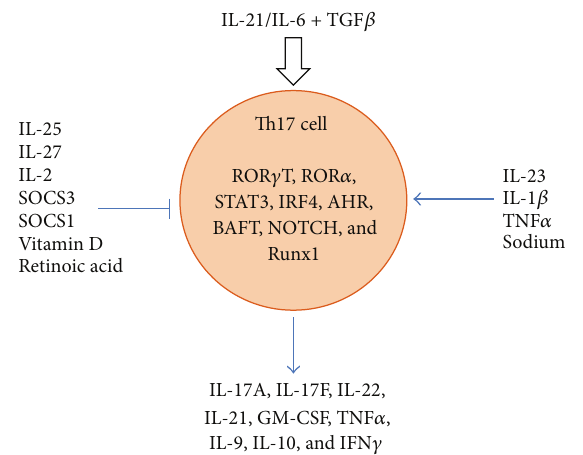
Figure 1: The world according to Th17 cells. Th17 cell induction occurs through combination of IL-6 and TGF 𝛽 , or IL-21 and TGF 𝛽 —in the absence of IL-6. The Th17 lineage produces cytokines which include IL-17A, IL-17F, IL-22, IL-21, GM-CSF, TNF 𝛼 , IL-9, IL-10, and IFN 𝛾 . This population is enhanced through IL-23, IL- 1 𝛽 , TNF 𝛼 , and high levels of sodium. Conversely, IL-25, IL-27, IL- 2, SOCS3, SOCS1, Vitamin D, and retinoic acid serve to negatively regulate Th17